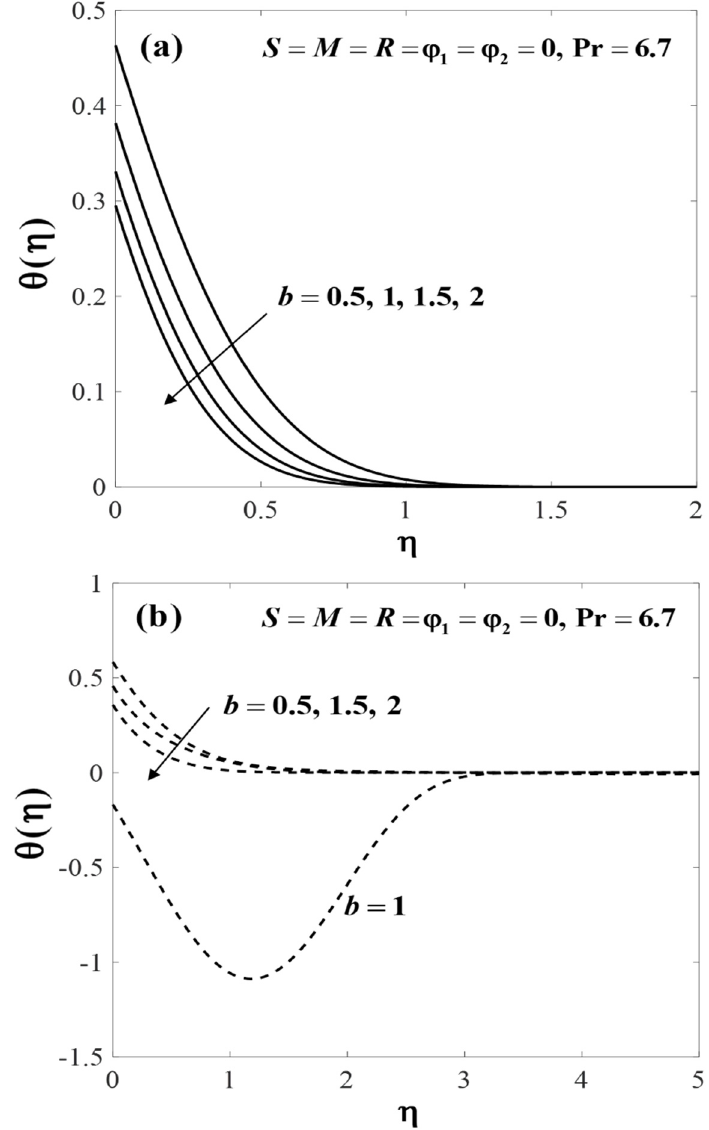
Figure 3. Impact of 𝑏 on 𝜃(𝜂) for ( a ) first solutions, and ( b ) second solutions.